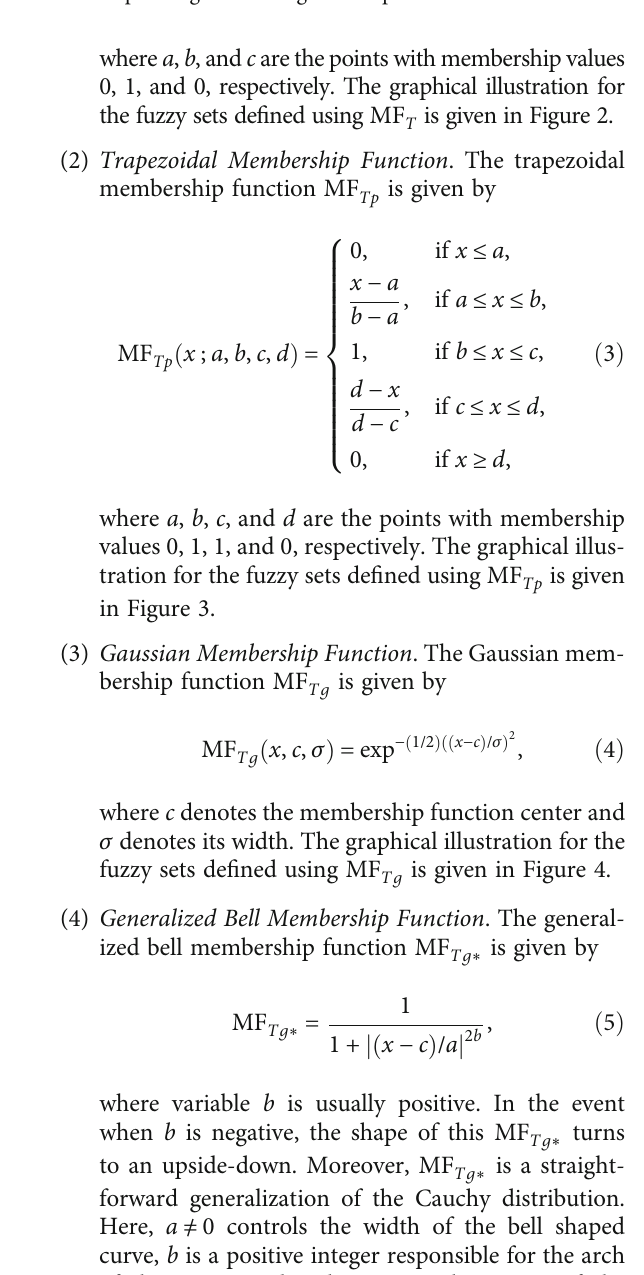
Figure 1: Fuzzy sets with di ff erent membership functions corresponding to the range of